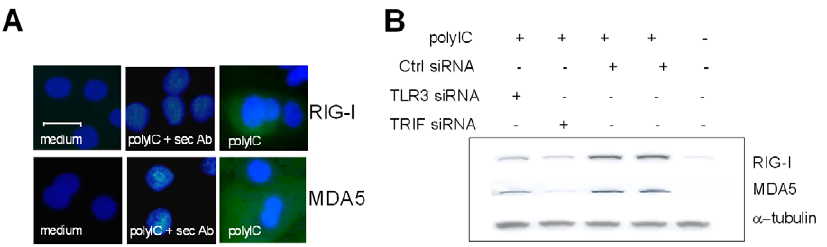
Figure 8. Role of TLR3 and TRIF in polyIC induced RIG-I and MDA5 protein. HBECs were treated with polyIC or medium and examined using immunofluorescence at 24 h for RIG-I (upper panel, A ) and MDA5 (lower panel, A ) . Both cytoplasmic RIG-I and MDA5 (in green) was induced after polyIC treatment at 24 h, compared to medium treated cells, or cells stained with secondary antibody only. Horizontal line indicates 20 m m scale. HBECs were treated with polyIC or medium for 8 h and the effects of TLR3 and TRIF siRNA on polyIC induced RIG-I and MDA5 assessed by western blotting (B). TLR3 and TRIF siRNA reduced RIG-I and MDA5 protein compared to control siRNA. a -tubulin was used to control for protein loading.